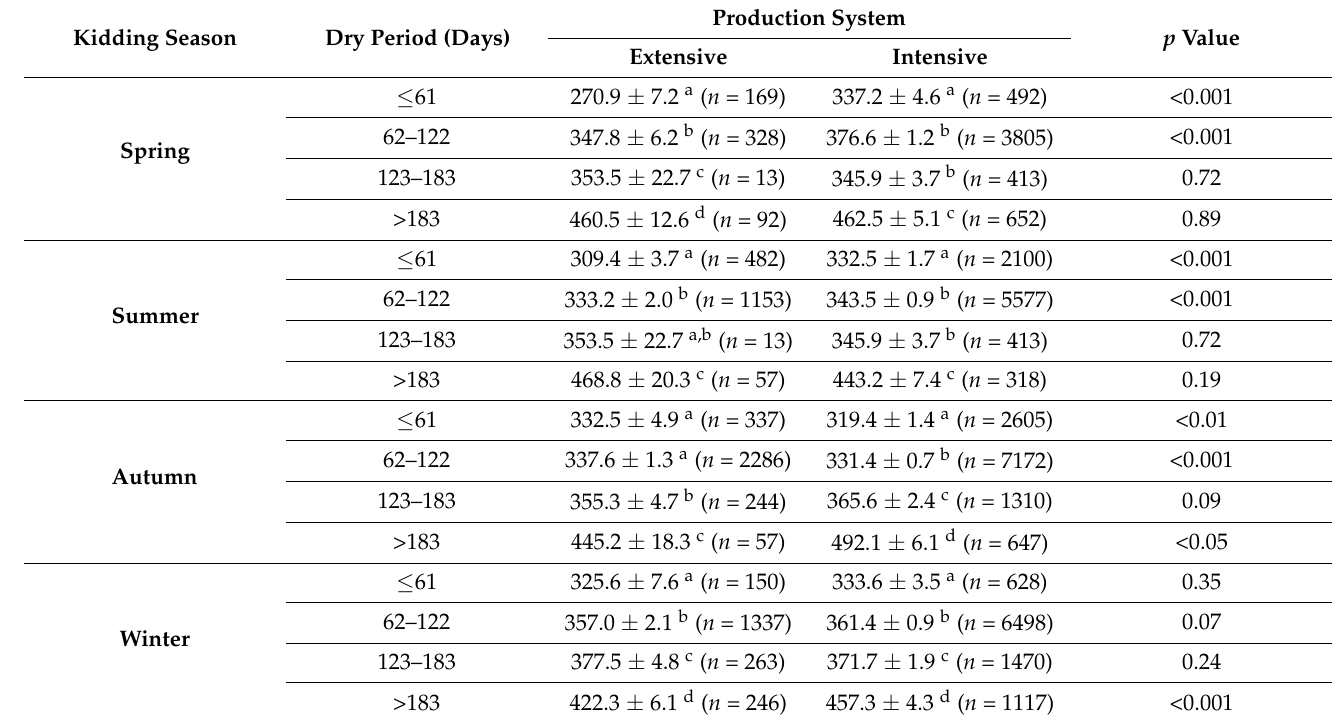
Table 2. Kidding interval (days ± SE) variation according to production system and kidding season for each dry period of Florida